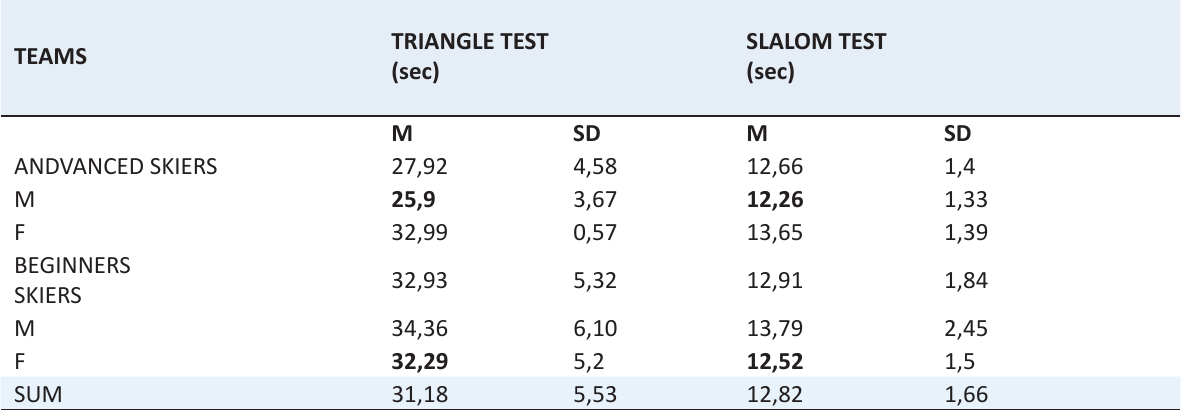
Table 4. The efficiency (time) of the triangle test and the slalom test in snow